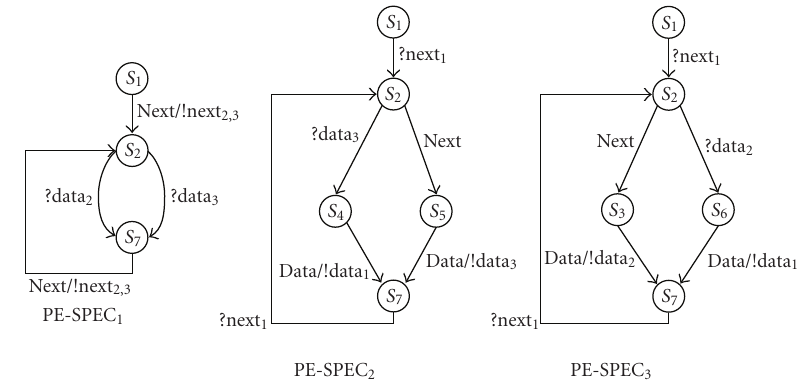
Figure 3: The PE-SPECs synthesized from the S-SPEC given in Figure 2.